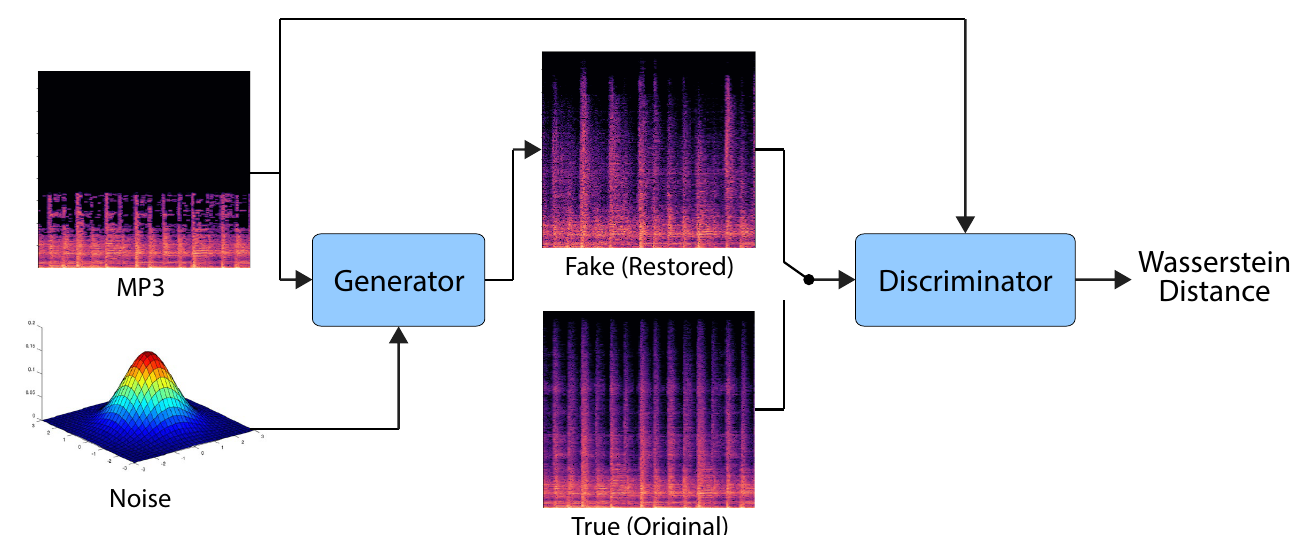
Figure 1. Schematic depiction of the architecture and training